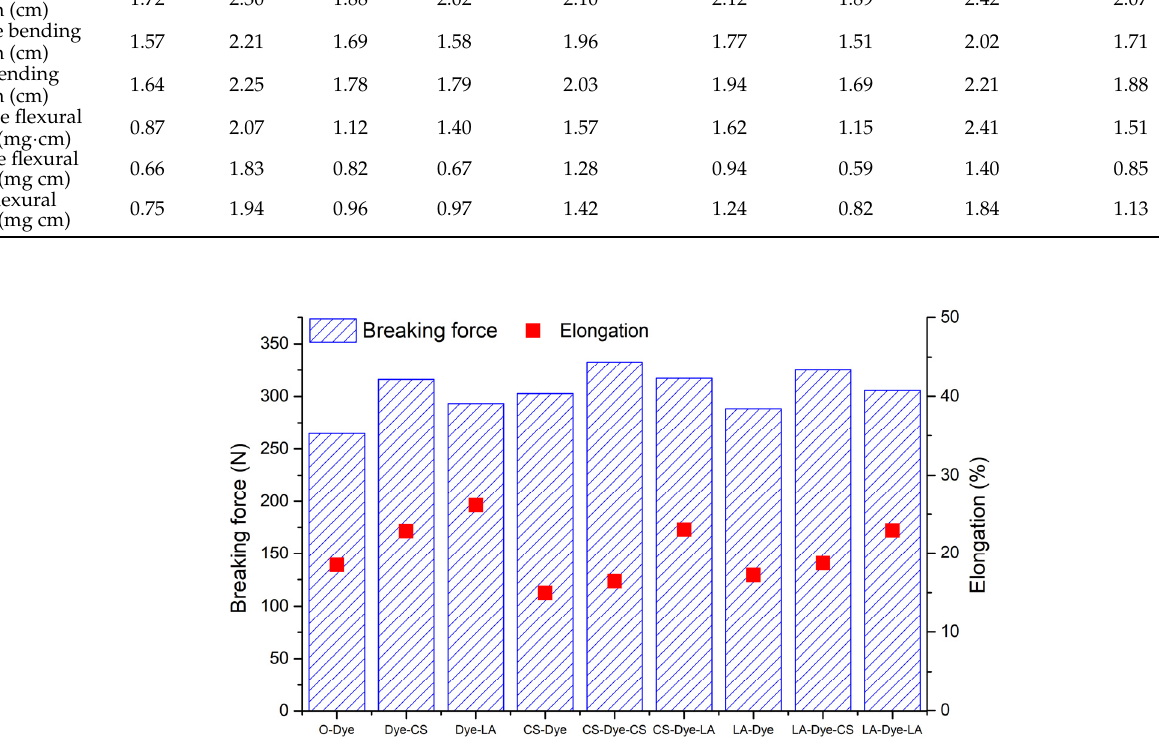
Figure 9. Breaking force and elongation of the original and mercerized woven cotton fabrics dyed with R2.